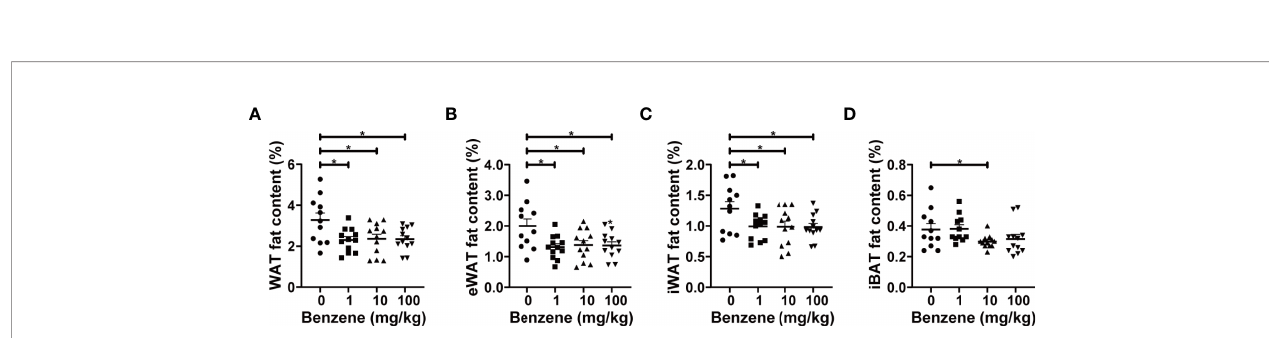
FIGURE 2 | Effect of benzene on body composition. Body fat content (A) , lean meat content (B) and free water content (C) were measured to re fl ect body fat distribution after benzene treatment. Data are presented as mean ± SD (n = 11-12). One-way ANOVA were performed; * p < 0.05 (compared to the control group).